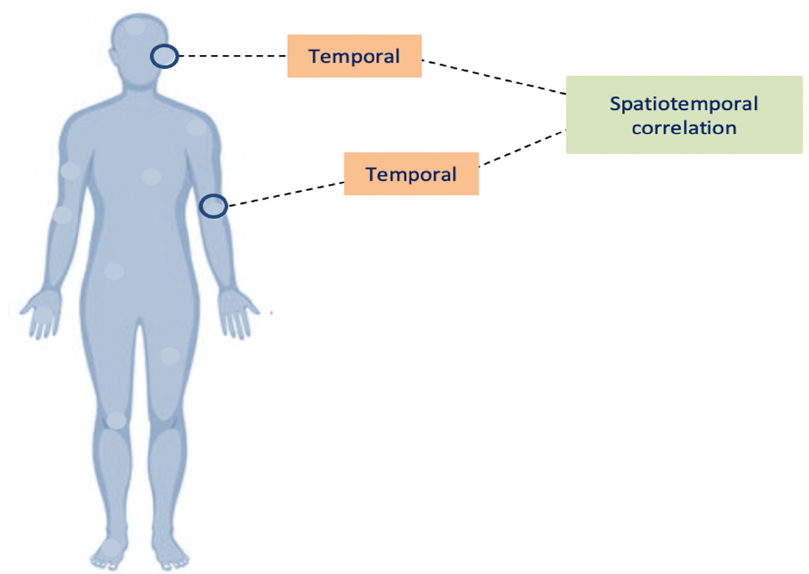
Figure 6. Concept for spatial and temporal correlation.